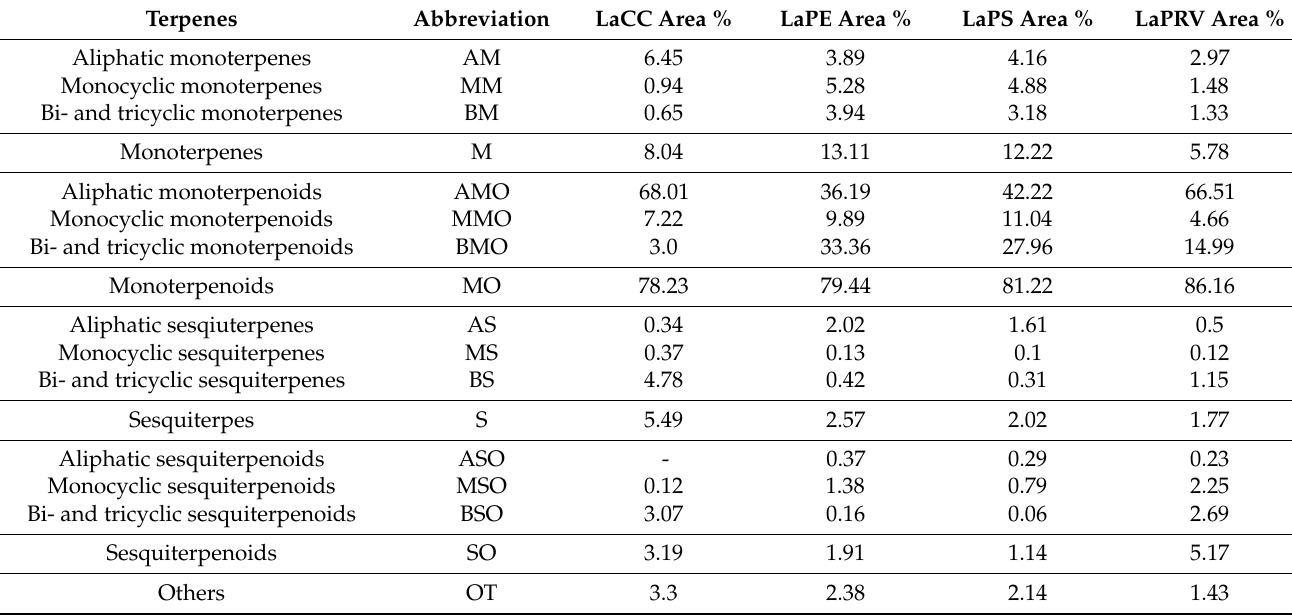
Table 2. List of terpenes in the lavender